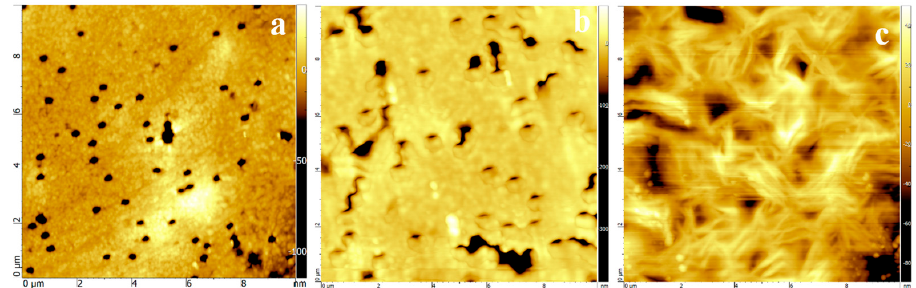
Figure 3. FTIR spectra of original PET TeMs in comparison with SM grafted PET TeMs at different concentrations of monomer.